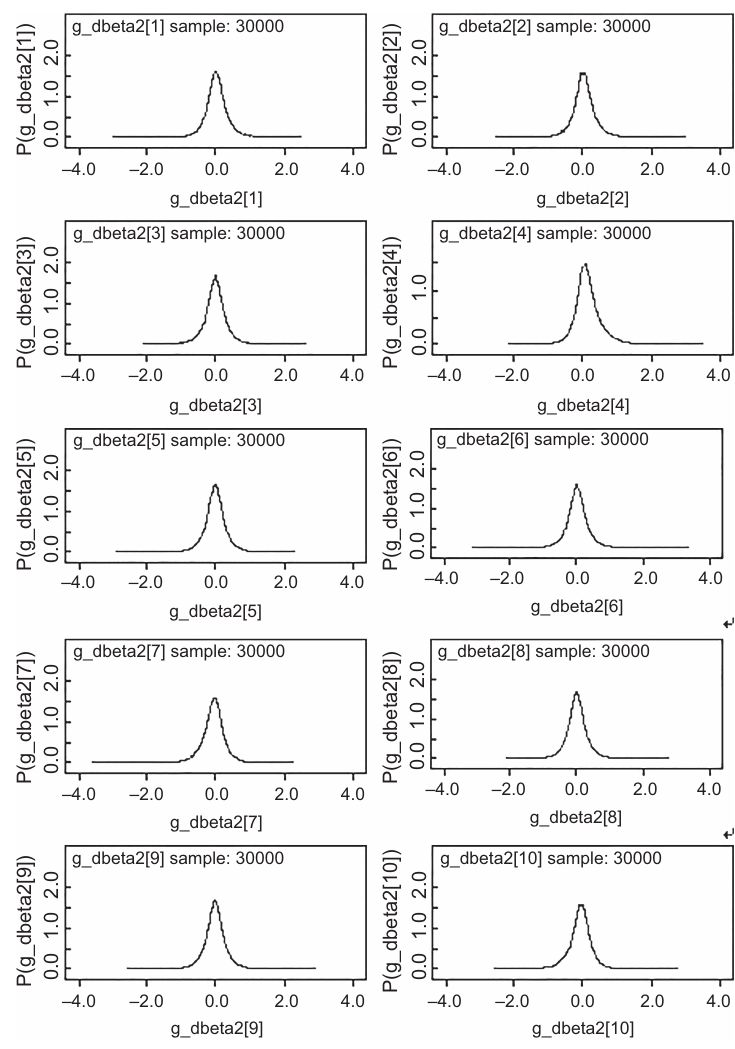
or plotting its density distribution, to assess if a structural change takes place with respect to the impact of income on the incidence of civil war in the period between these years. According to the caterpillar plots drawn earlier, possible changepoint years are the 4th, 6th, 25th, 47th and 48th. Hence, simulations of the coefficients for these years are compared with their previous year ’ s values, respectively, and the density distributions of the differences between those sequences are reported in Figure 7.